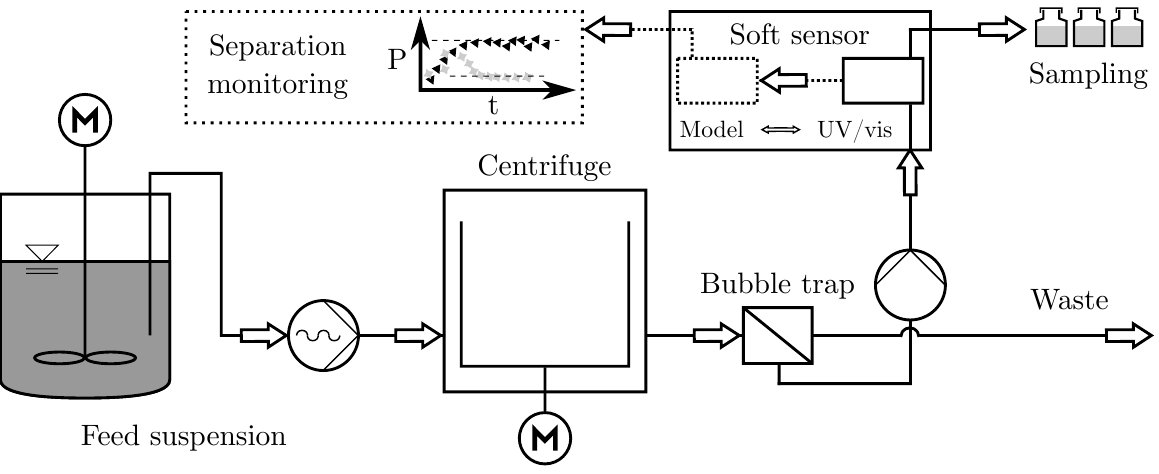
Figure 3. Schematic flow sheet of the monitored separation process. The separated fine fraction passes over the overflow weir into a collection tray and is ejected irregularly into the process downstream. A bubble trap separates the suspension– air mixture into a product and waste stream. The fine material, freed from micron sized bubbles, is fed into the UV/vis hardware sensor with a peristaltic pump and a volumetric flow rate of 60 mL min − 1 . Sampling takes place at the sensor outlet with no dead time